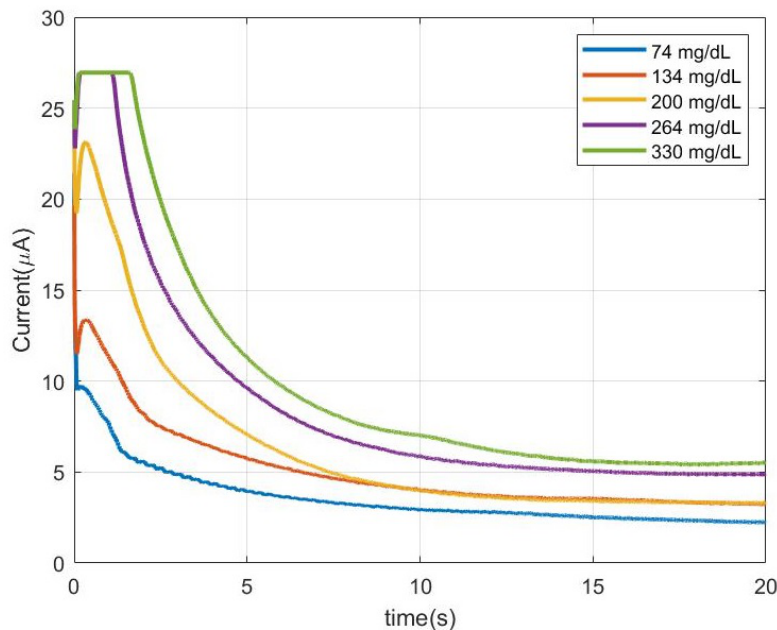
Figure 18. Measured current as a function of time for different glucose concentrations.